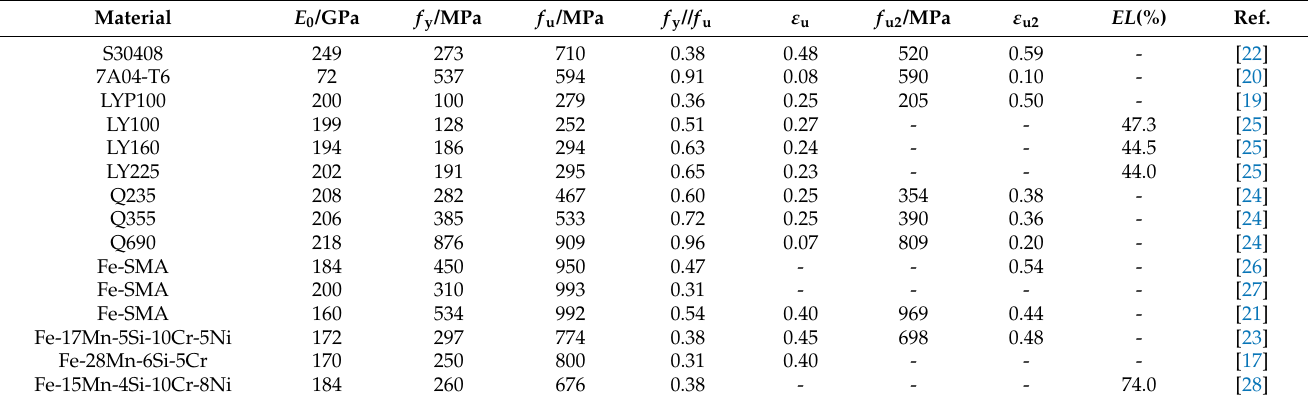
Table 3. Mechanical properties of different metallic materials under quasi-static monotonic loading tests.